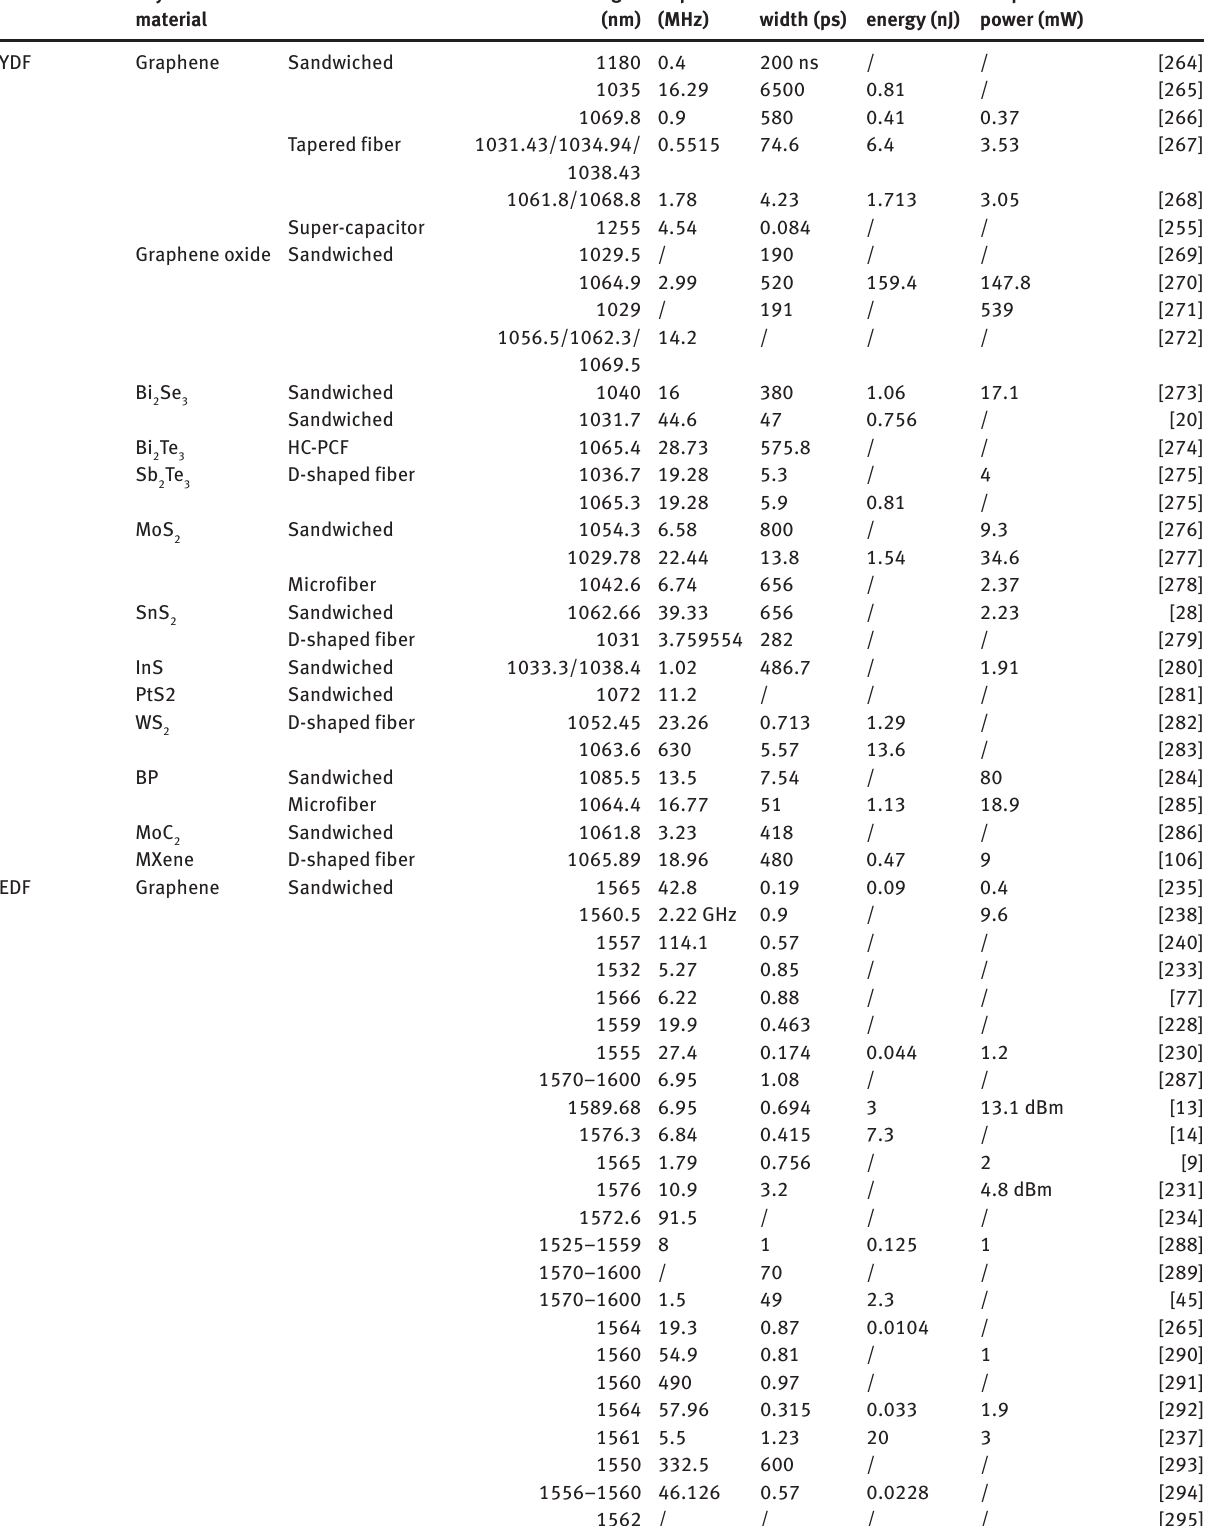
Table 4: Summary of mode-locked fiber lasers based on layered 2D materials. Gain medium Layered